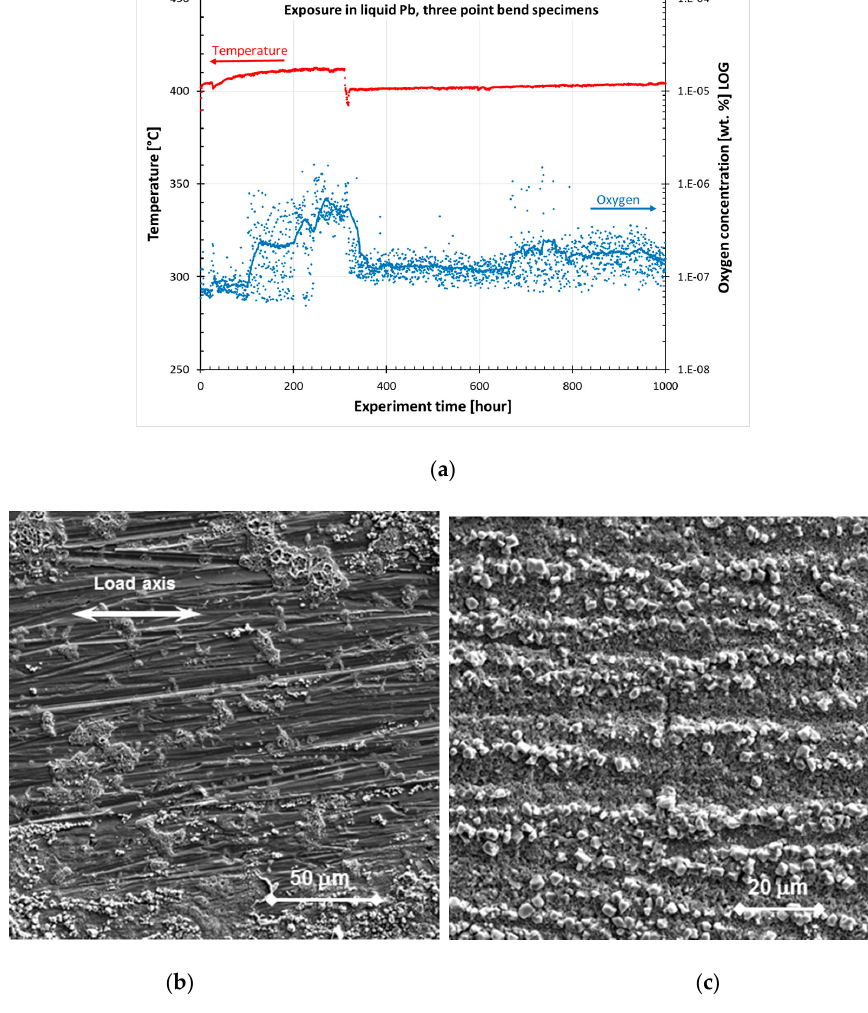
Figure 3. Bend specimens’ exposure in liquid Pb: ( a ) Time dependence of temperature and oxygen content. ( b , c ) SEM images of the surface after the 1000 h exposure in Pb and chemical cleaning from Pb showing places with ( b ) non-continuous (T001) and ( c ) continuous oxide layer